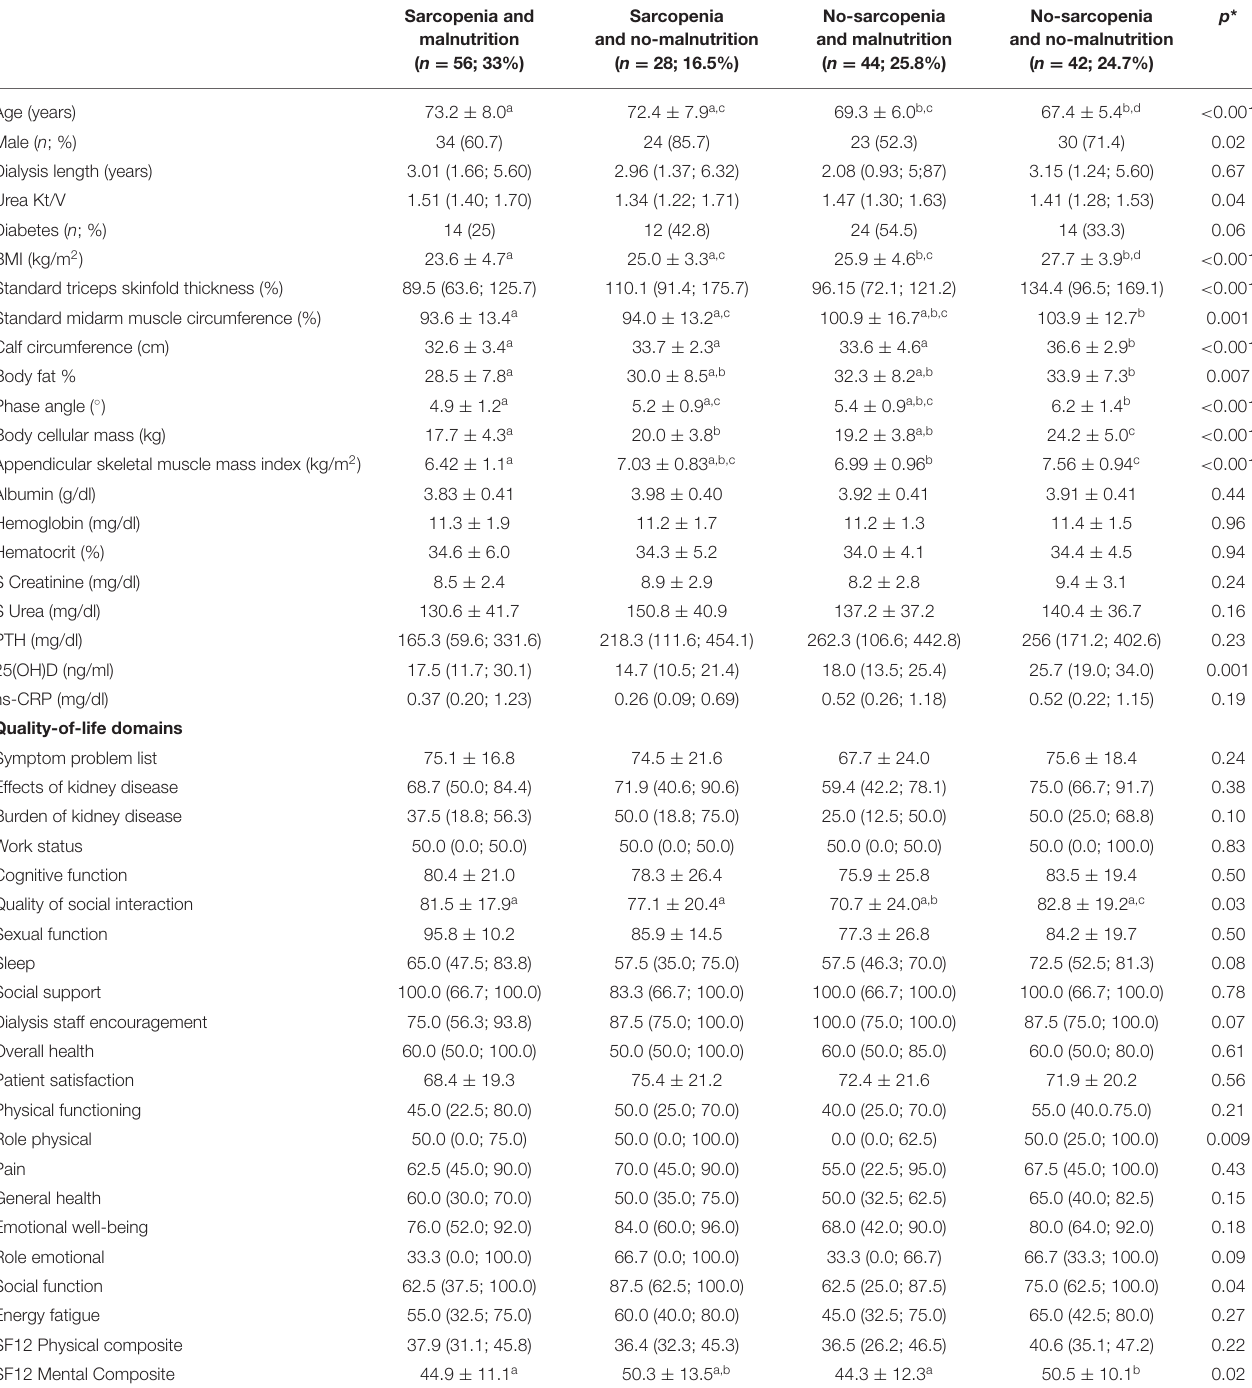
TABLE 2 | Comparisons of demographic, nutritional, clinical characteristics, and quality of life of older adults on hemodialysis according to the groups sarcopenia and malnutrition.